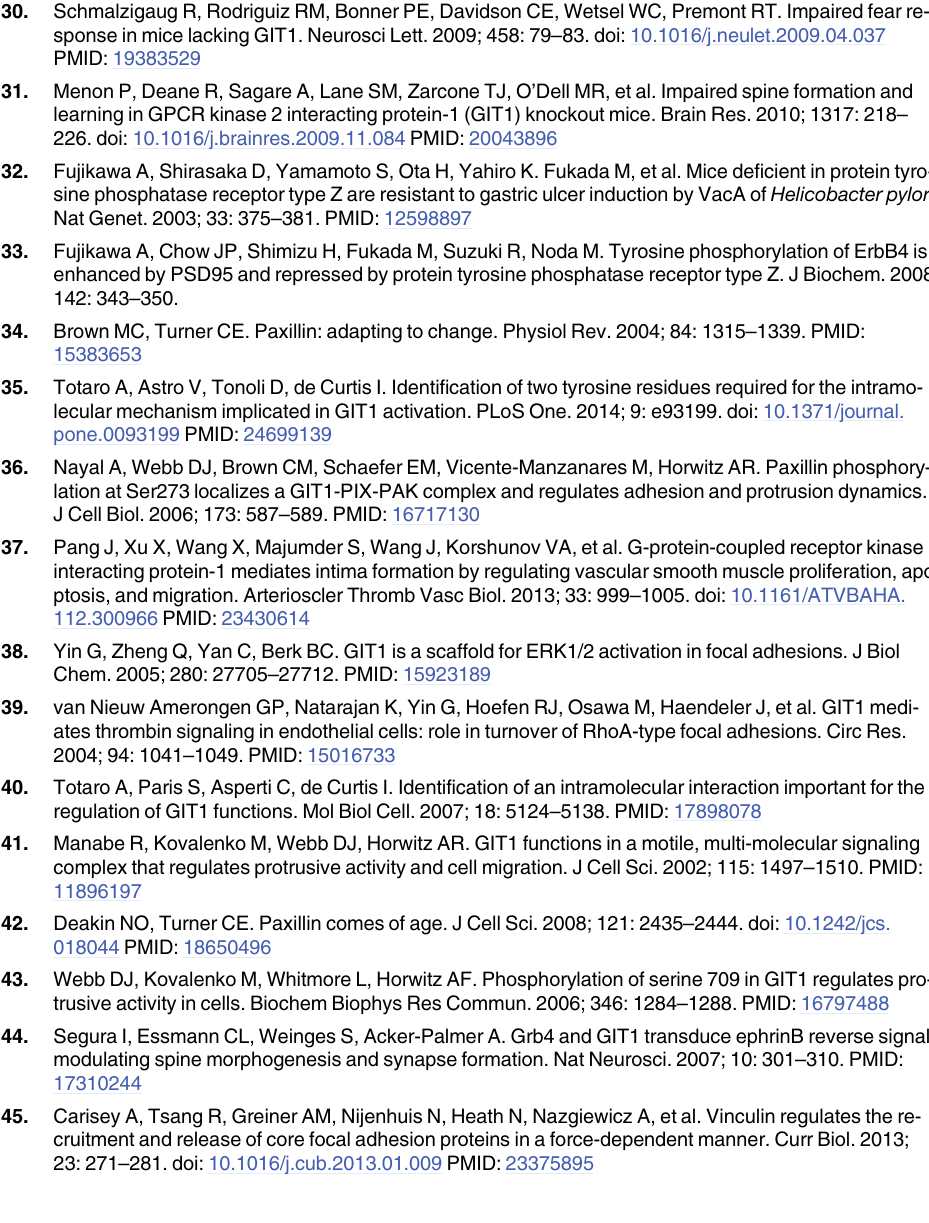
PLOS ONE | DOI:10.1371/journal.pone.0119361 March 5,